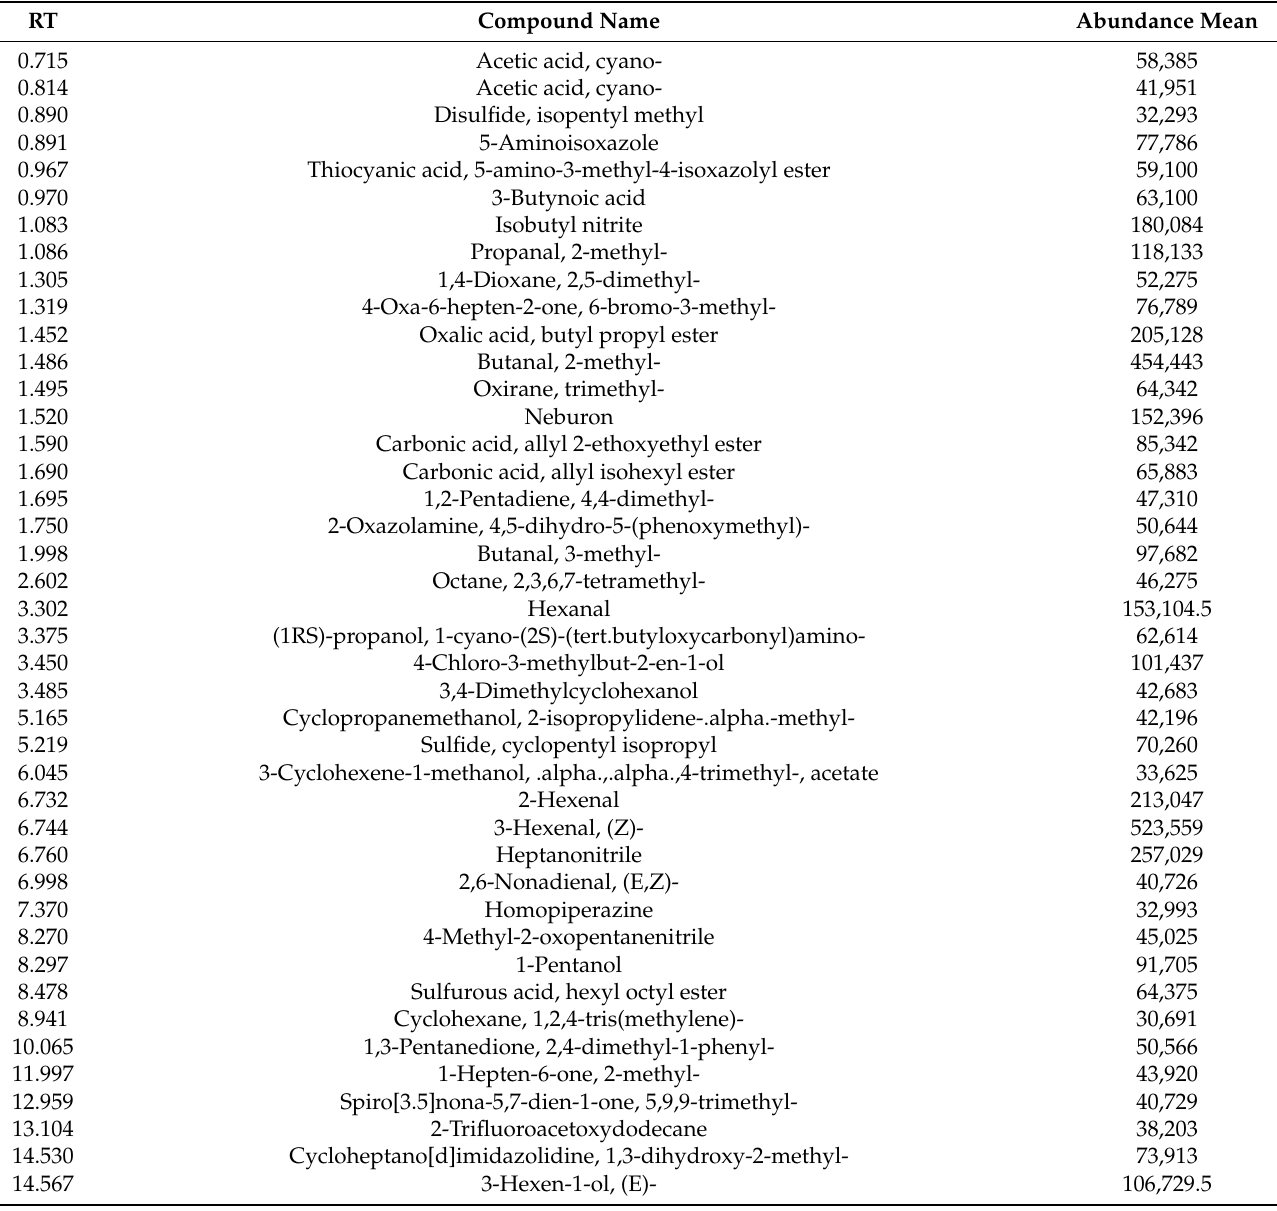
Table A10. Results for the TBC sample fingerprint determination with indication of the retention time (RT) and abundance mean for every identified